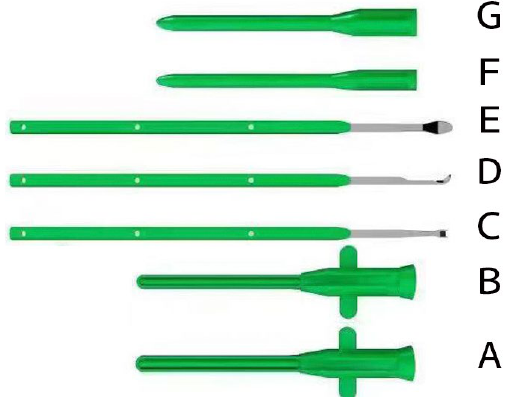
Figure 1. Modified Soft Tissue Release Kit. ( A ) Thick (7 mm) cannula with a lining core; ( B ) Thin (6 mm) cannula with a lining core; ( C ) Spade knife; ( D ) Hook knife; ( E ) Detacher; ( F ) Thin (6 mm) expander; ( G ) Thick (7 mm) expander.